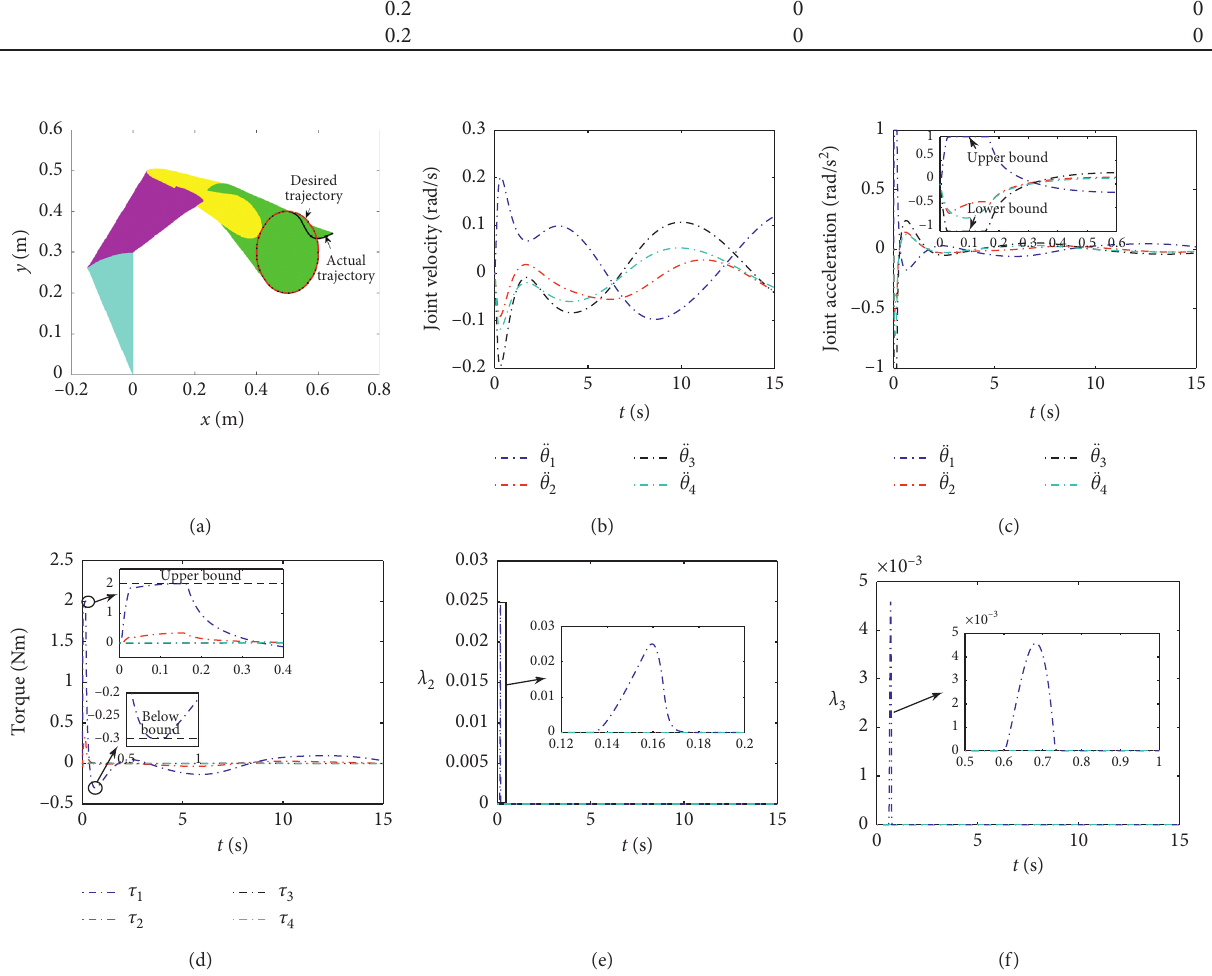
. (f) State variables λ 2 3